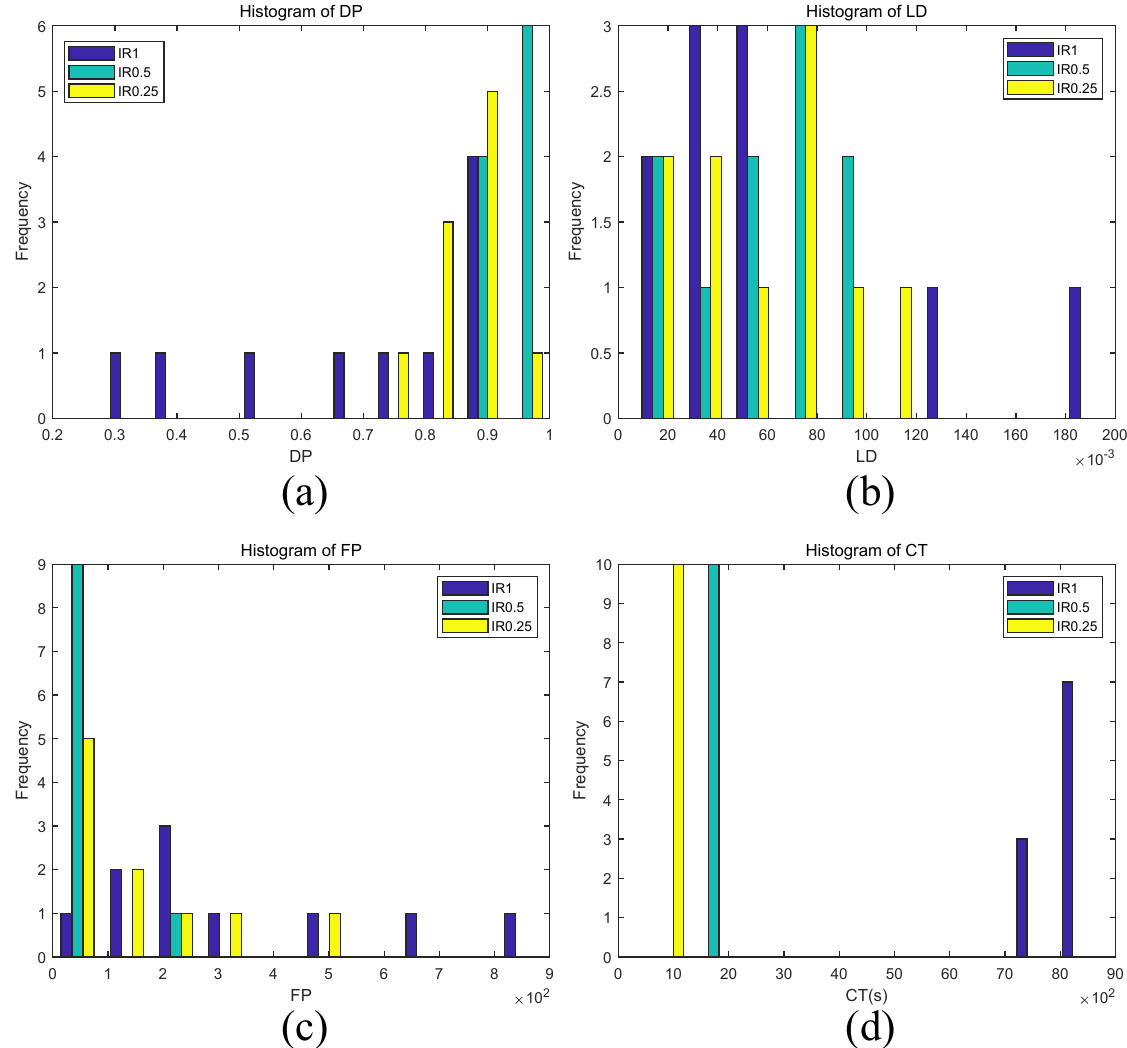
Figure 4. Histogram results of DP , LD , FP and CT of the proposed method with three different scale factors, 0.25, 0.5 and 1: ( a ) DP histogram, ( b ) LD histogram, ( c ) FP histogram and ( d ) CT